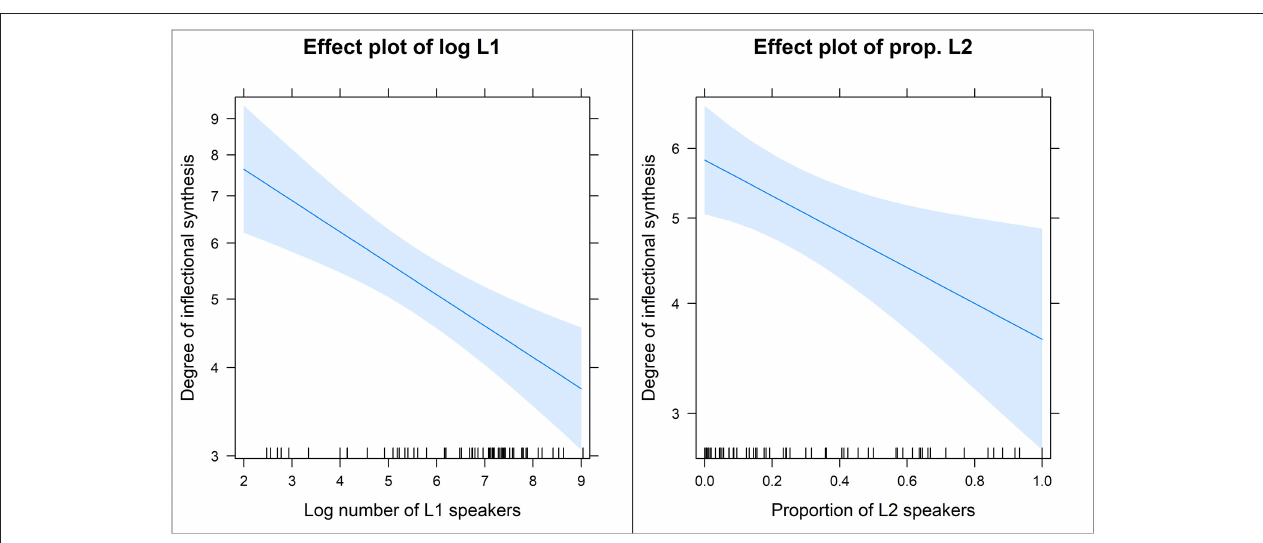
FIGURE 8 | Effect plots of the model predictors in model SYNTHESIS.ALL (log number of L1 speakers on the left and the proportion of L2 speakers on the right).